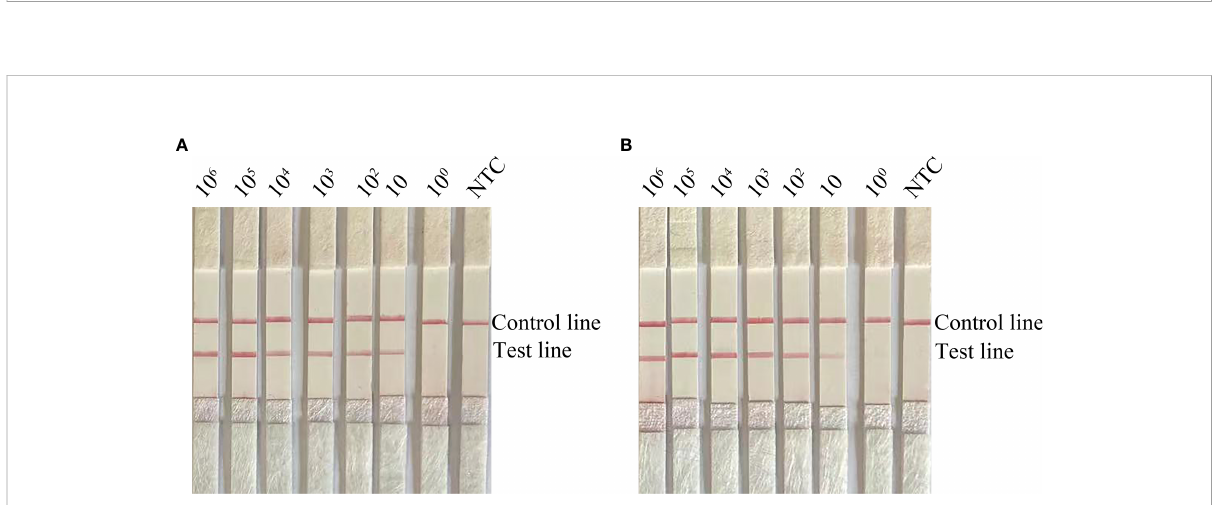
FIGURE 2 Determination of the limit of detection (LOD) of the C. krusei RPA-LFS assay. (A) The LOD for the RPA-LFS assay for C. krusei was established with the primer-probe set F5/P/R2B on genomic DNA extracted from an inactivated bacterial broth of C. krusei at serial dilutions from 10 0 to 10 6 CFU for each reaction. The image shows the results of the RPA-LFS. The number of templates is indicated at the top of the bar graph. (B) Picture showing the results of the RPA-LFS assay with primer-probe set F5/P/R2B and 10 6 CFU of C. glabrata for